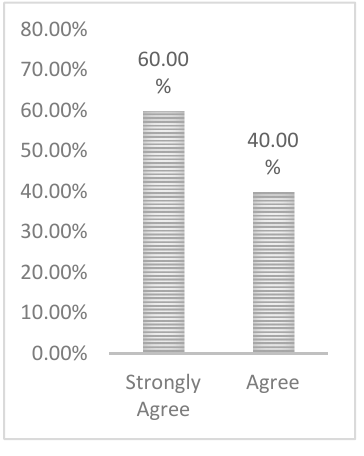
Figure 2. FOMO-R coverage.